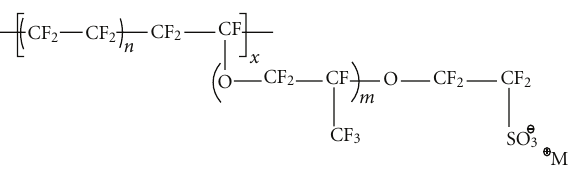
Figure 2: Chemical structure of Nafion. Table 1: Atomic concentration percentages of the characteristic elements found on the membranes surfaces.